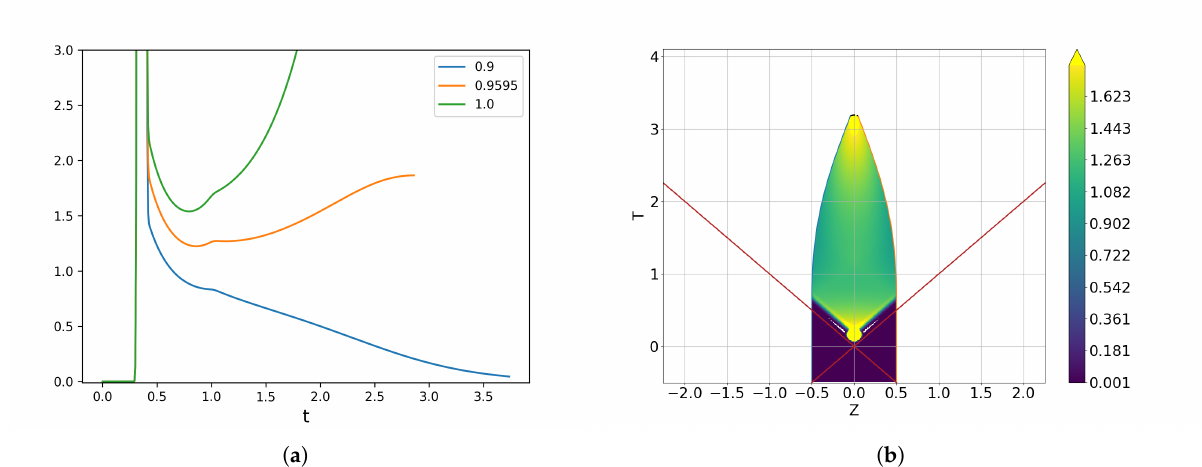
Figure 15. ( a ) The Weyl invariant I with λ = 0.6 along u = v , i.e., z = 0, for multiple values of a close to a 2 and ( b ) a contour plot of I for a =